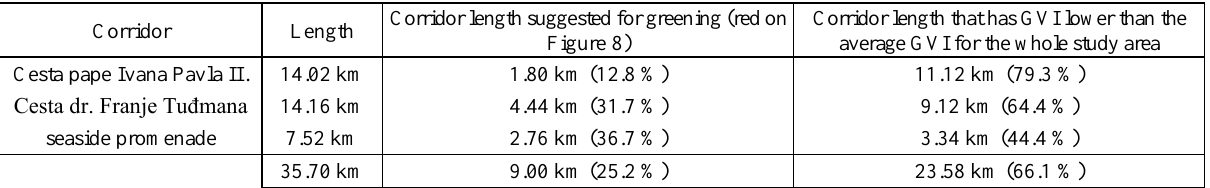
Table 4. Lengths of each corridor, and lengths of the corridors that are suggested for additional greening, and that have lower GVI than the average GVI value on the whole study area Table 5 presents the area and percentage of vegetation for each planned land use category for years 2015 and 2019. Additionally, changes that occurred in the vegetation in the period from 2015 to